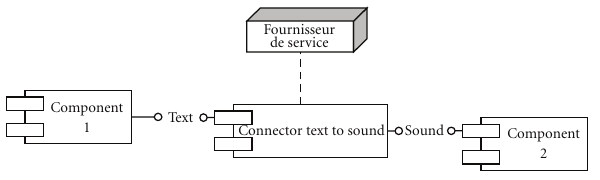
Figure 17: Relation